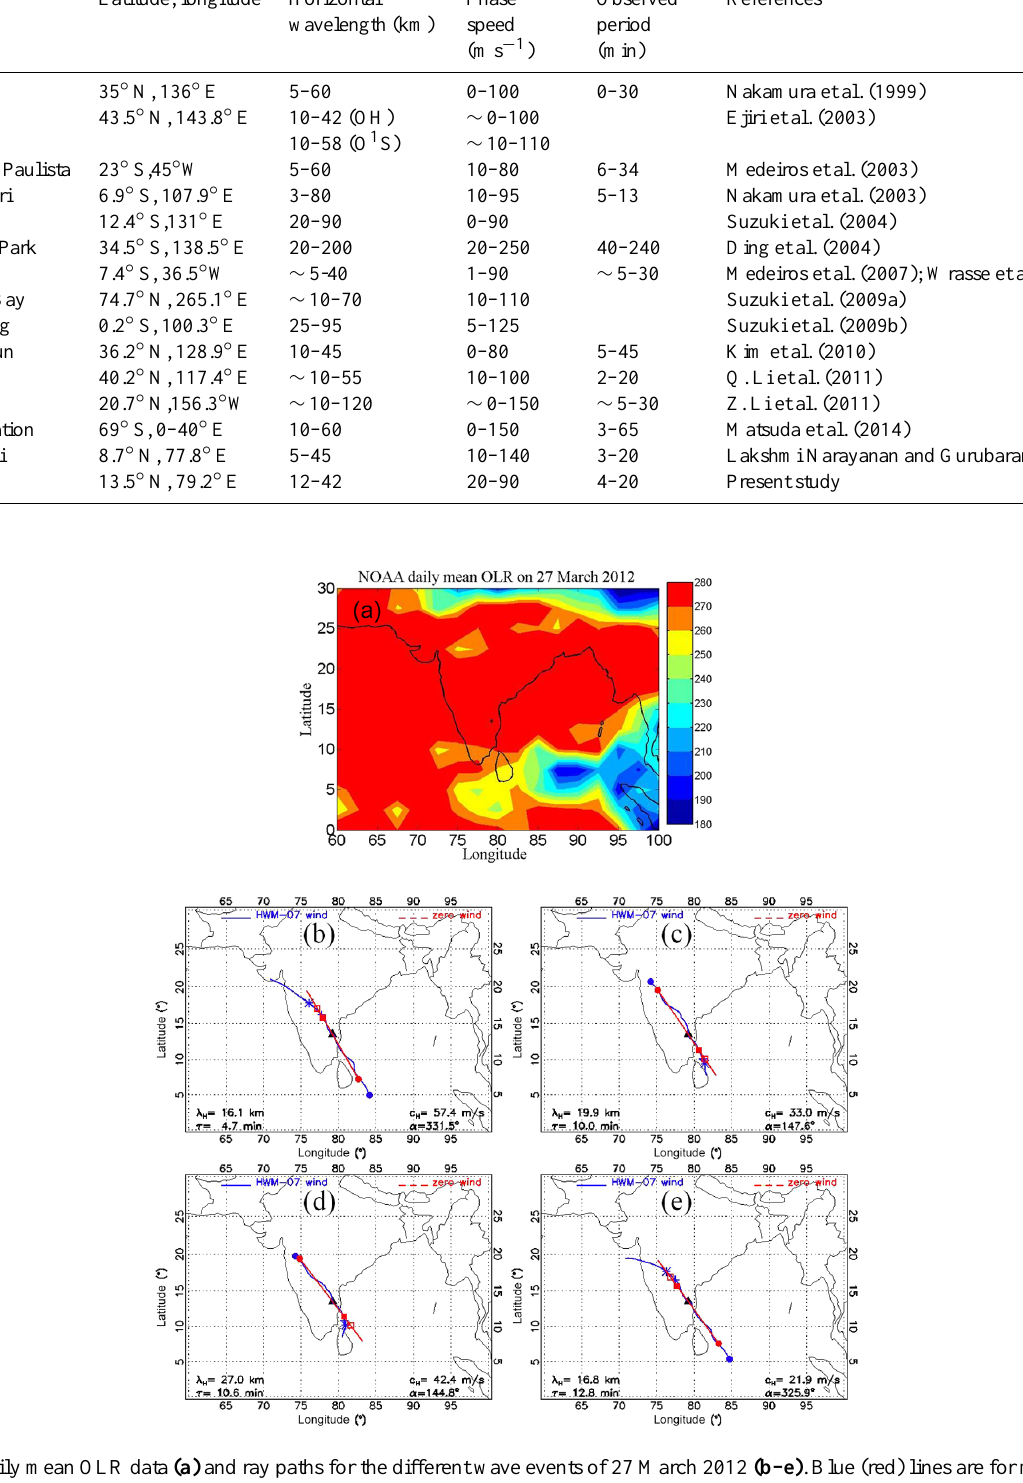
Atmos. Meas. Tech., 9, 93–102,